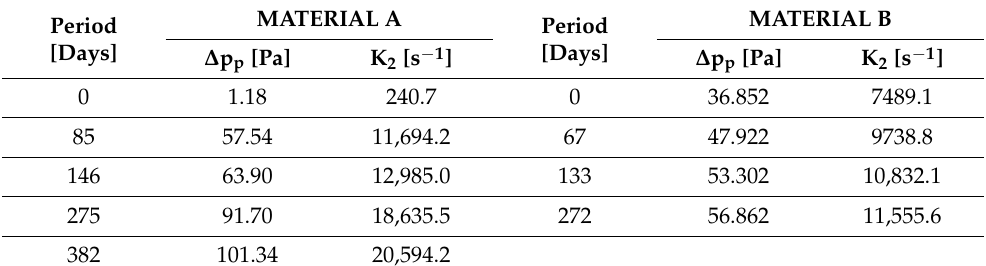
Table 6. Summary of dust layer resistance values for individual test variants and the dust resistance